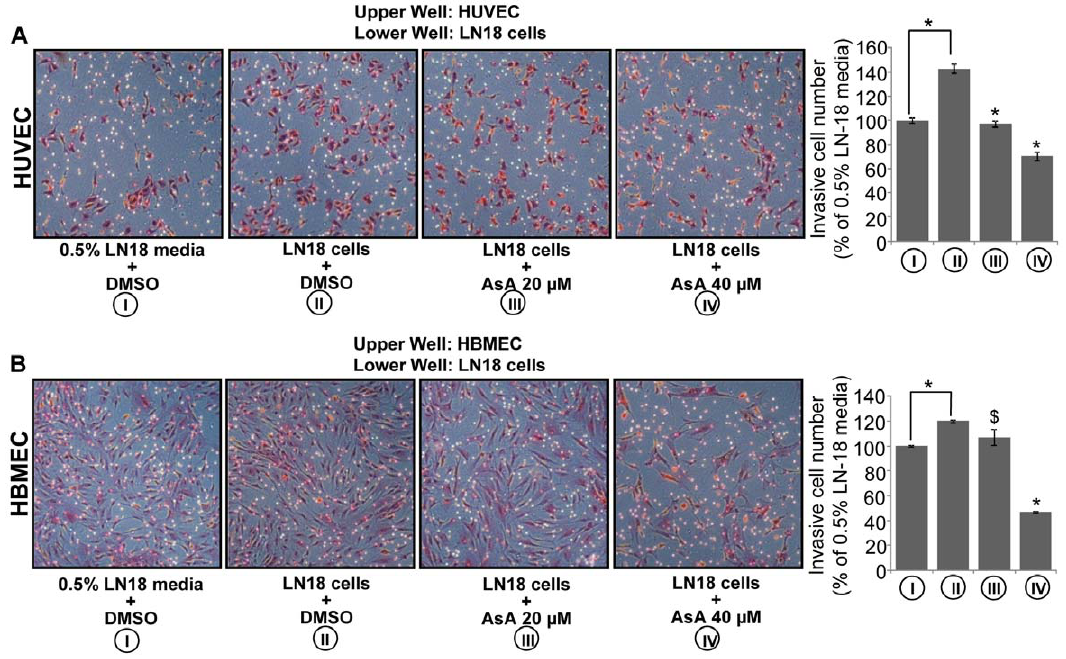
Figure 6. AsA inhibits glioma cells induced chemotactic motility of endothelial cells. A & B. HUVEC or HBMEC (3 6 10 4 per well) were seeded in the upper chamber of a Transwell plate with 0.5% serum media. In the lower chamber, LN18 cells (3 6 10 4 cells per well) were treated with DMSO or AsA 20 m M in 0.5% serum media as described in ‘Materials and Methods’. HUVEC and HBMEC migrated through the matrigel layer were stained and quantified after 10 h and 22 h of their plating in the upper chamber respectively. Cell invasion data shown are mean 6 standard deviation of three samples for each treatment. *, p # 0.001; $ , p # 0.05.